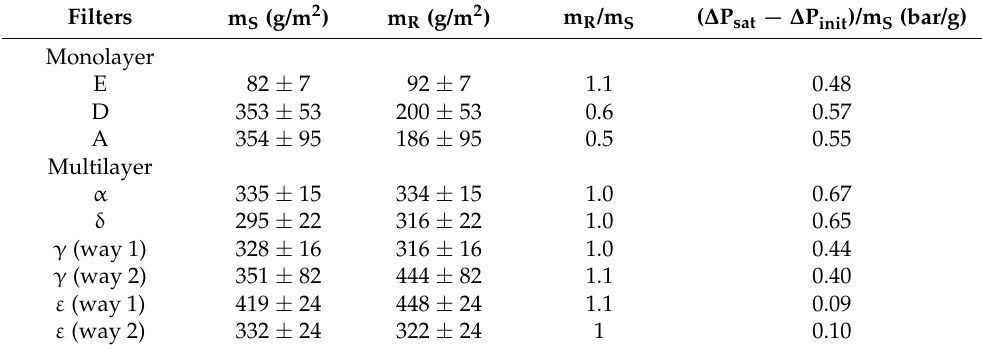
Table 4. Summary of main